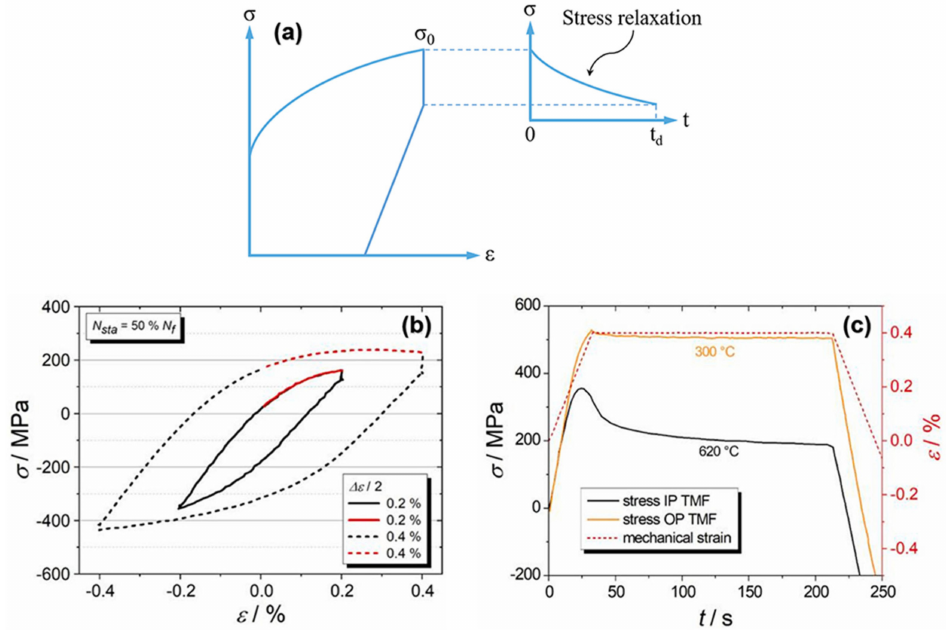
Figure 1. ( a ) Schematic illustration of the stress relaxation, and ( b , c ) stress relaxation in the stress- strain hysteresis loop at the half − life cycle and tensile strain dwell, respectively